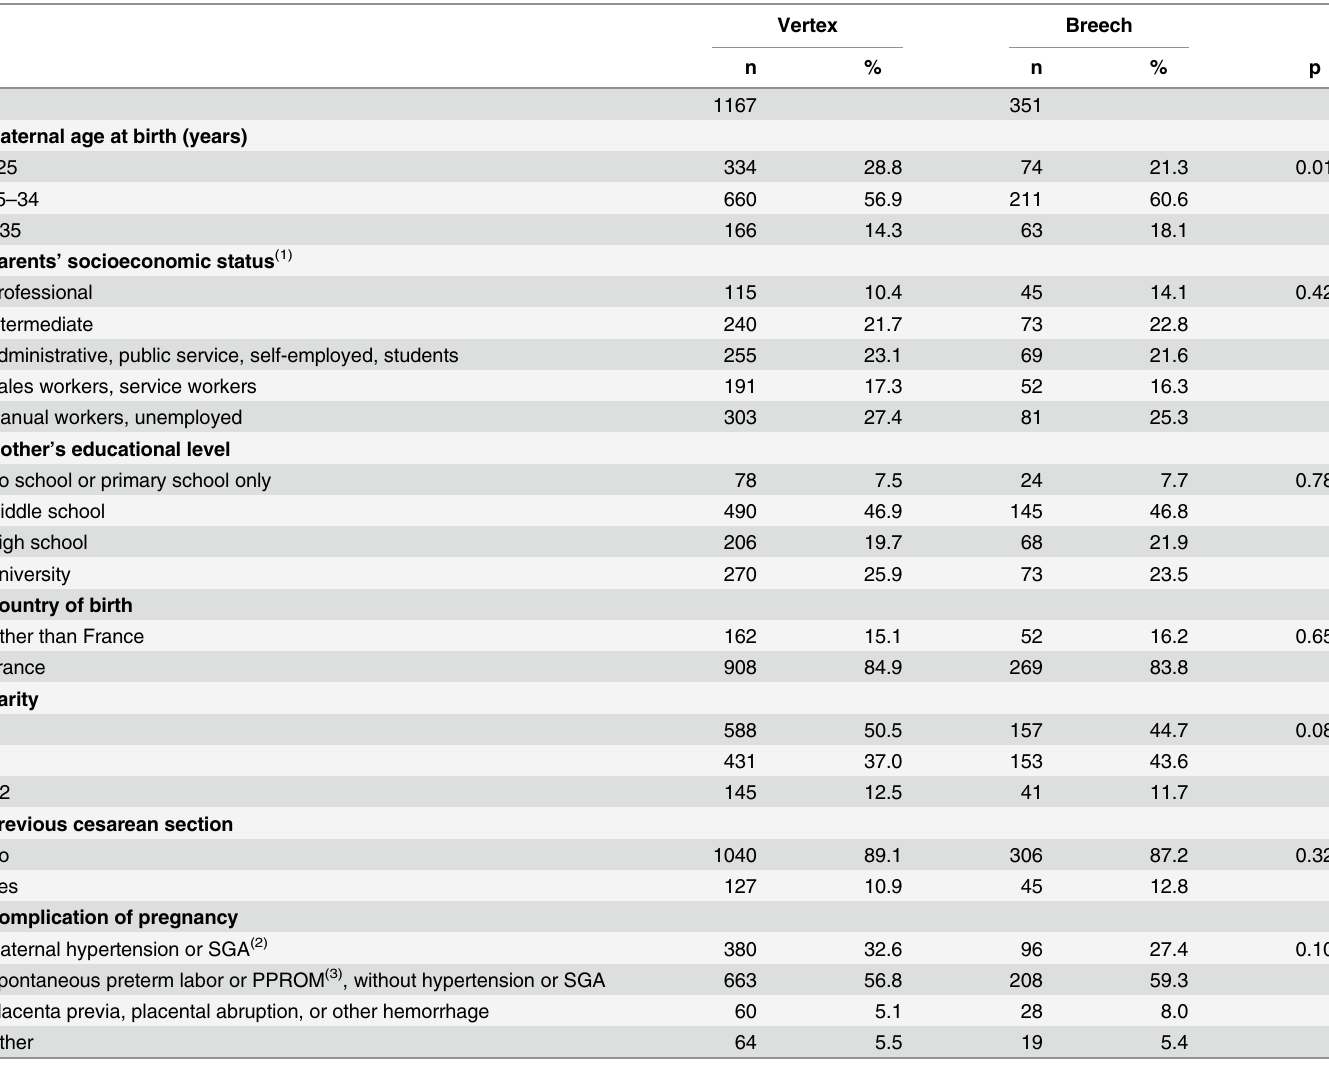
Table 2. Maternal and pregnancy